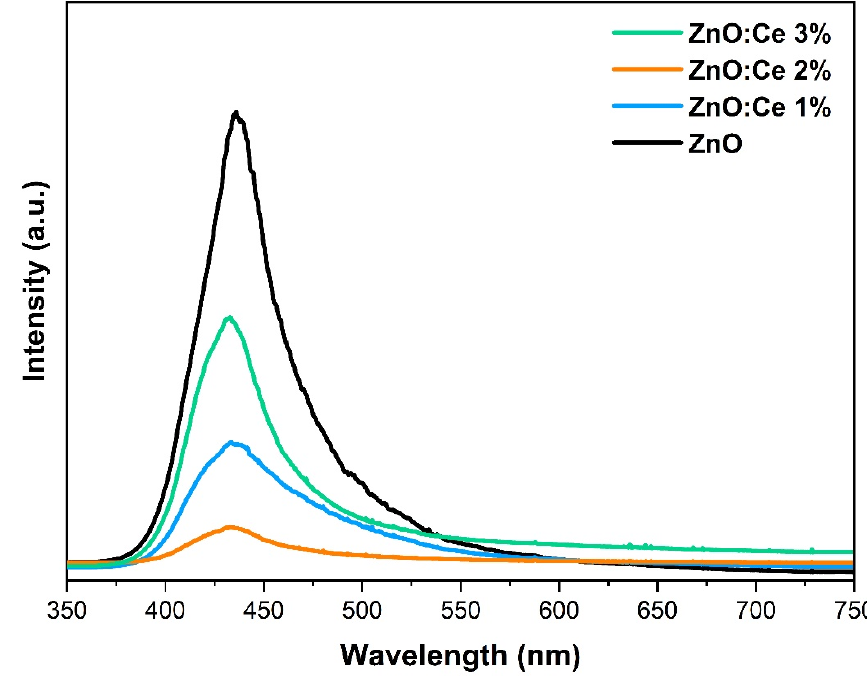
Figure 11. Photoluminescence spectroscopy (PL) spectra of the pure and Ce-modified ZnO